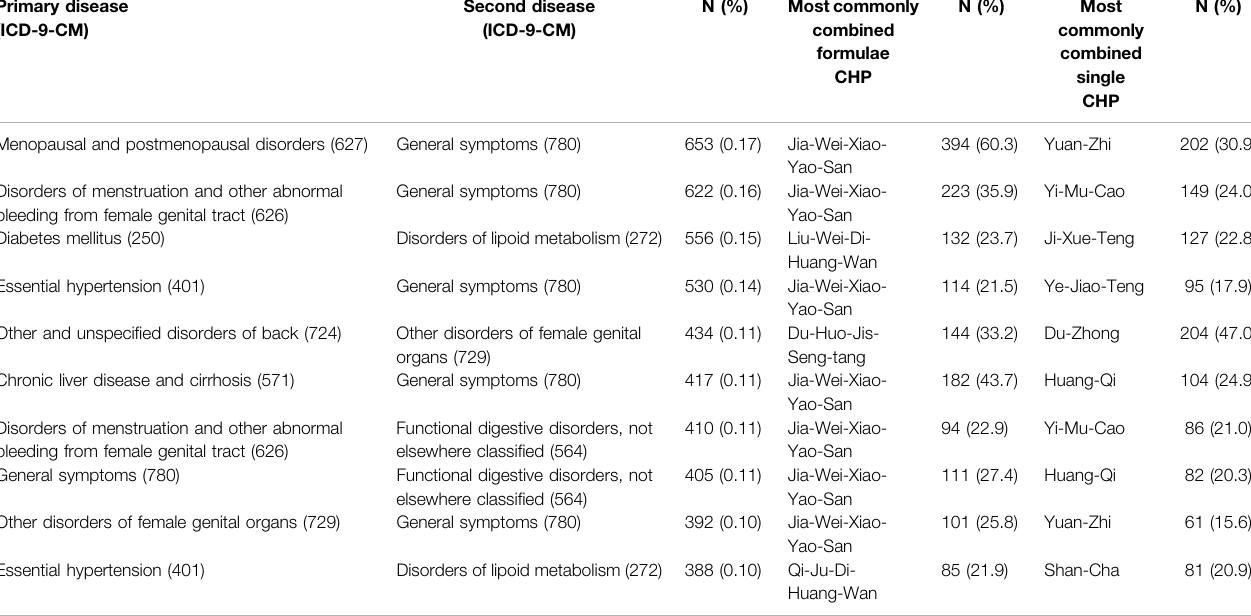
TABLE 3 | Top 10 combinations of two diseases treated with radix Salvia miltiorrhiza from 2000 to 2011 in Taiwan. Primary disease